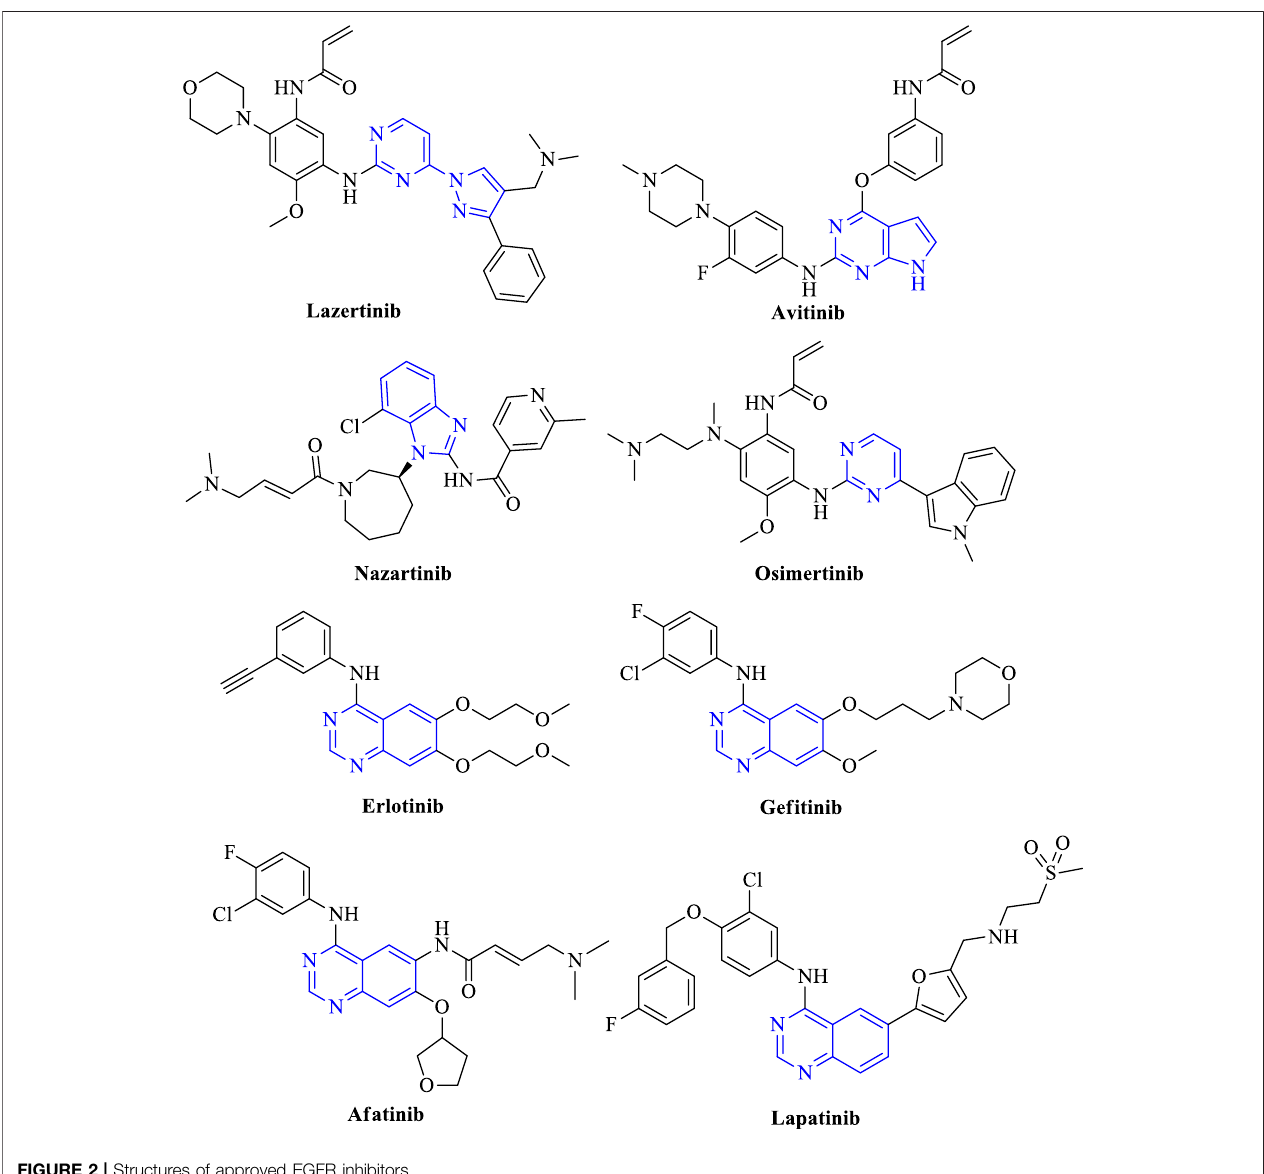
FIGURE 2 | Structures of approved EGFR